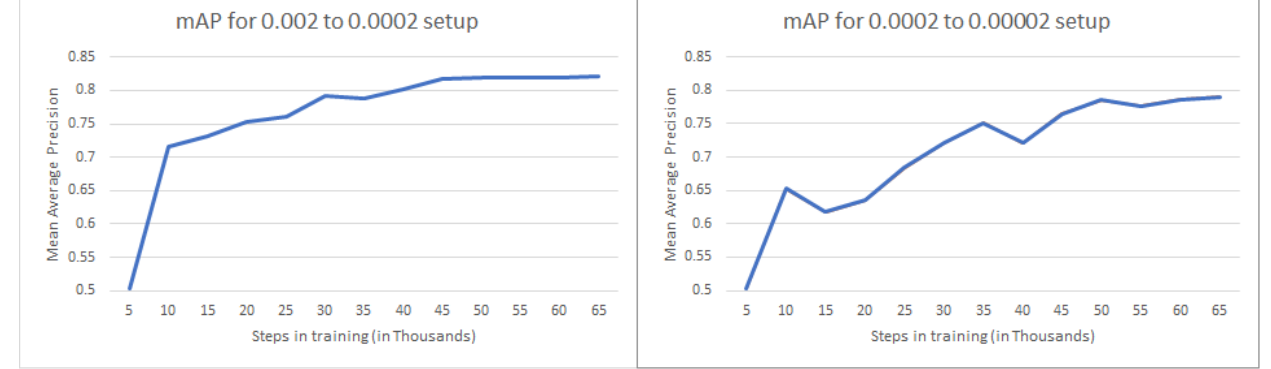
Figure 7. Mean average precision for both setups. Real-time testing of the application was carried out in the locations where they are most likely to exist or where food is consumed, such as convenience stores located inside the premises of the university, food courts, and areas reserved for students to relax. These areas have different lighting conditions. As expected, during real-time validation, the accuracy of the model was affected (increase in misclassifications and decrease in confidence levels) by factors such as lighting, angling, and the image being out of focus. A model with 0.8211 mAP was used for testing in a real-time setup. There were 100 tests for the three classes (coke, apples, and oranges). As seen in Table 2, apples and oranges were correctly identified approximately 90% of the time, while coke cans were correctly identified 60% of the time. Calorie estimation was tested with the 0.8211 mAP model. It was used to estimate the calories of a Coca-Cola can, apples, and oranges 100 times; when the classification was correct, it returned an average calorie count. The average calorie count of these three classes was within a 10% error of the actual calories. The predictions can vary from the ground truth, as listed in Table 2, and this deviation can be very large at times. Coca-Cola